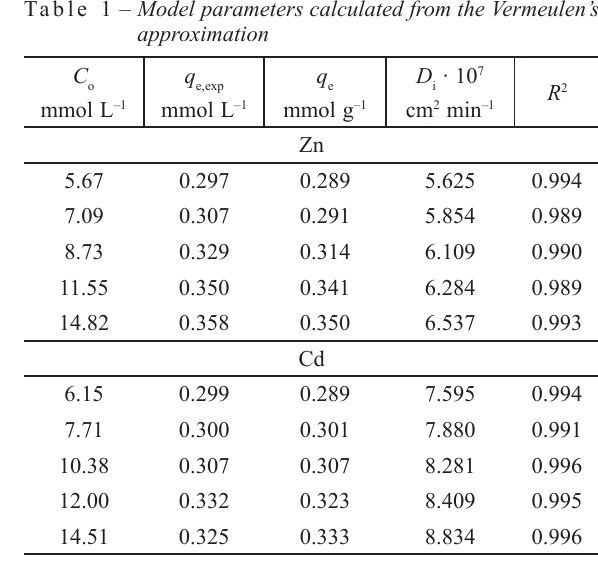
Table 2 – Relation q